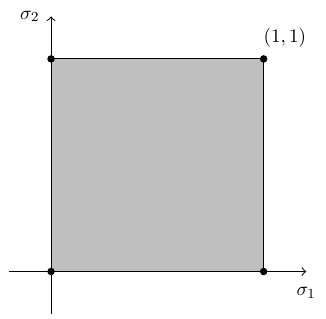
Figure 1 . Polytope of b ( z ) = 1 + z 1 + z 2 + cz 1 z 2 . Written as intersection of half planes, we have (cid:1) b = f (cid:27) 1 (cid:21) 0 g \ f (cid:27) 2 (cid:21) 0 g \ f(cid:0) (cid:27) 1 (cid:21) (cid:0) 1 g \ f(cid:0) (cid:27) 2 (cid:21) (cid:0) 1 g